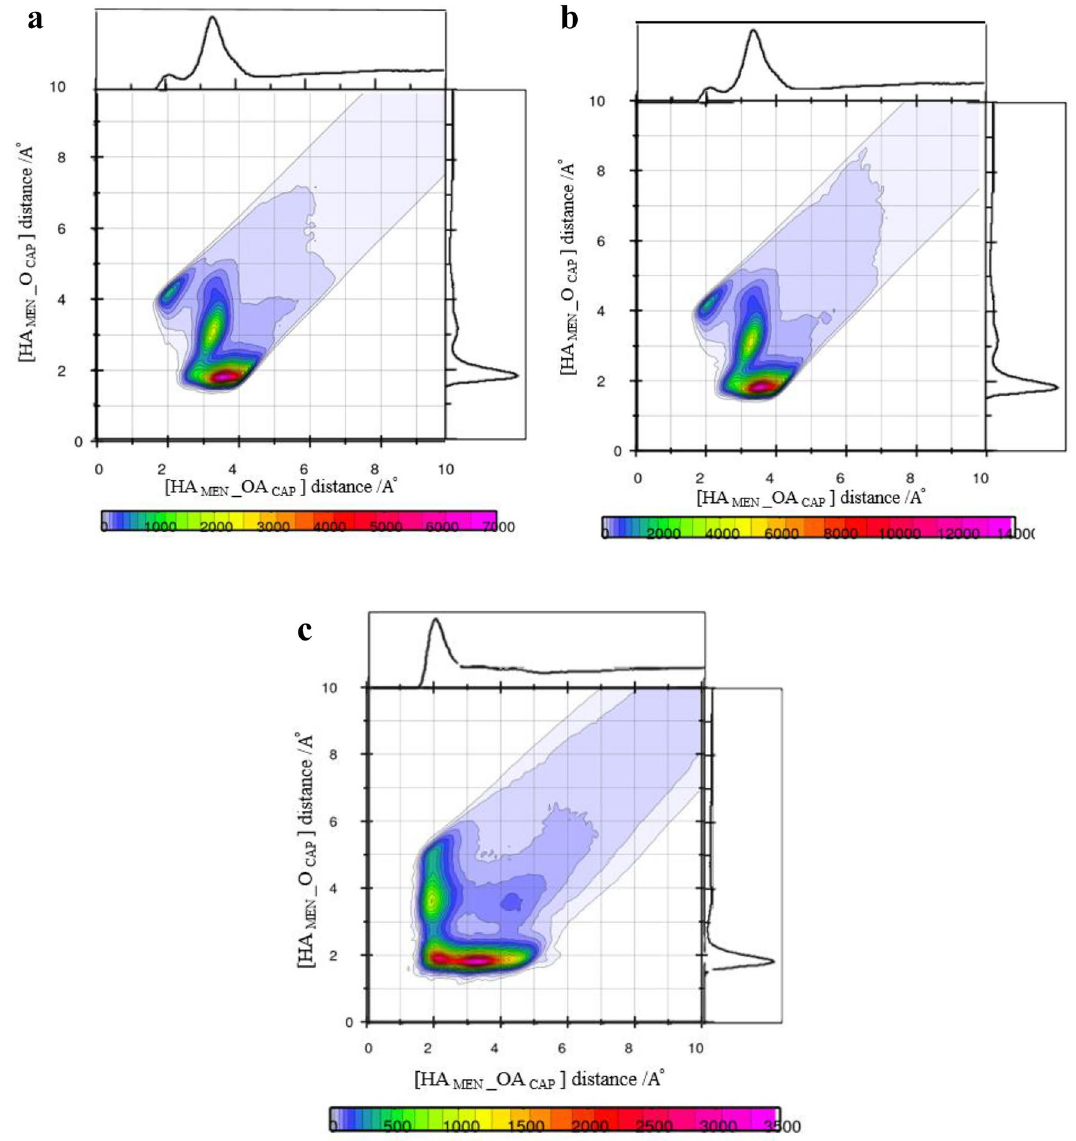
Figure 9. ( a ) Combined radial/radial distribution functions for ( a ) the HA MEN _O CAP distance and HA MEN _ OA MEN distance, in the binary mixtures with % CAP = 20 at 323 K, ( b ) for the HA CAP _O CAP distance and HA CAP _OA MEN distance, in the binary mixtures with % CAP = 44 at 323 K, ( c ) the HA CAP _O CAP distance and HA CAP _OA MEN distance, in the binary mixtures with % CAP = 70 at 323